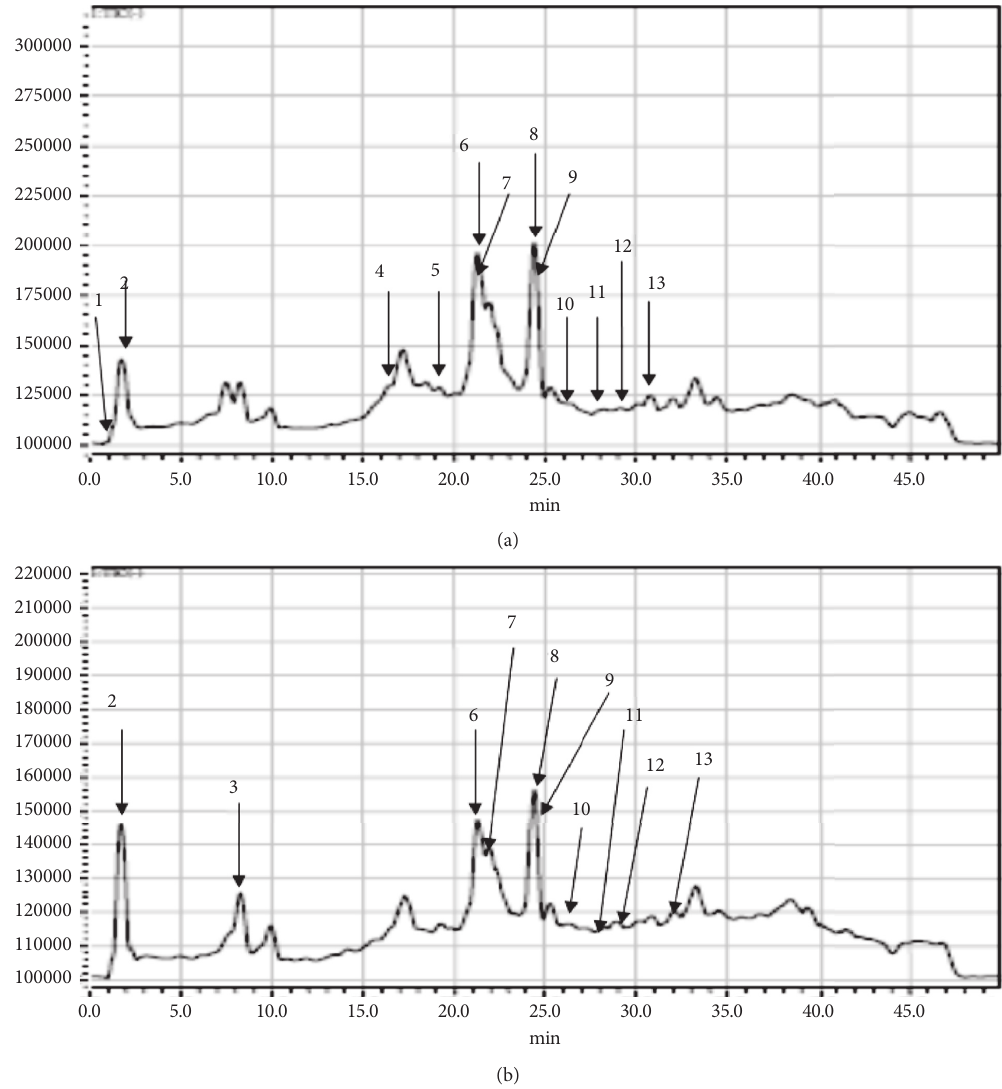
Figure 5: HPLC chromatograms of the phenolic compounds of the extracts obtained by maceration (a) and ultrasound (b) extraction methods.1, quinic acid; 2, gallic acid; 3, protocatechuic acid; 4, p -coumaric acid; 5, trans -ferulic acid; 6, hyperoside; 7, rutin; 8, quercetrin; 9, naringin; 10, salviolinic acid; 11, trans -cinnamic acid; 12, quercetin; 13,